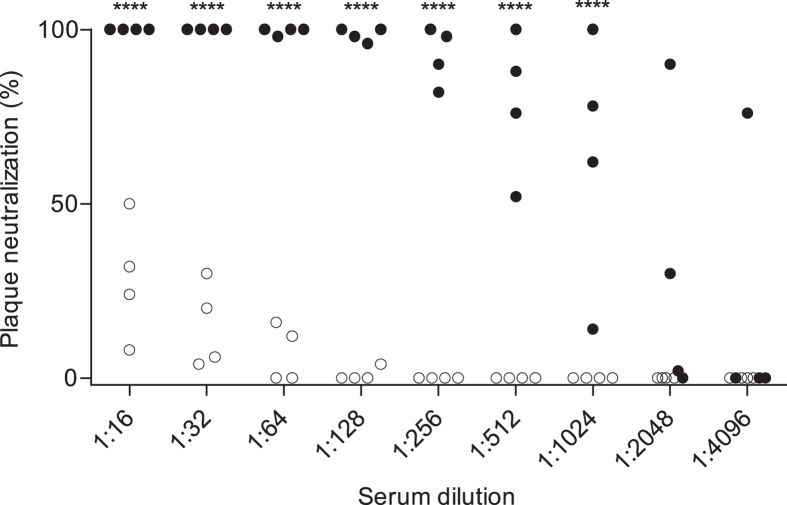
Anti-VP1 antibodies inhibit CVB plaque formation.Plaque neutralization tests using CVB3 were performed with 8 representative sera that were selected based on their anti-CVB profile (Supplementary Fig. 3) as strong anti-VP2 and VP1 antibodies (filled symbols), or strong anti-VP2 antibodies only (open symbols). Despite similar anti-VP2 titers in each serum, the anti-VP1 high titer sera had >100-fold stronger neutralization capacity than the anti-VP1 deficient sera. ****p-value < 0.0001 based on repeated measures ANOVA with Bonferroni post-test comparisons.